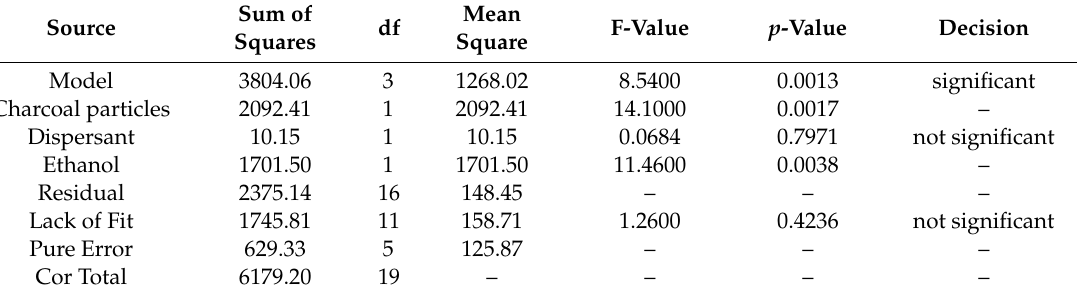
Table 6. ANOVA for the linear model of